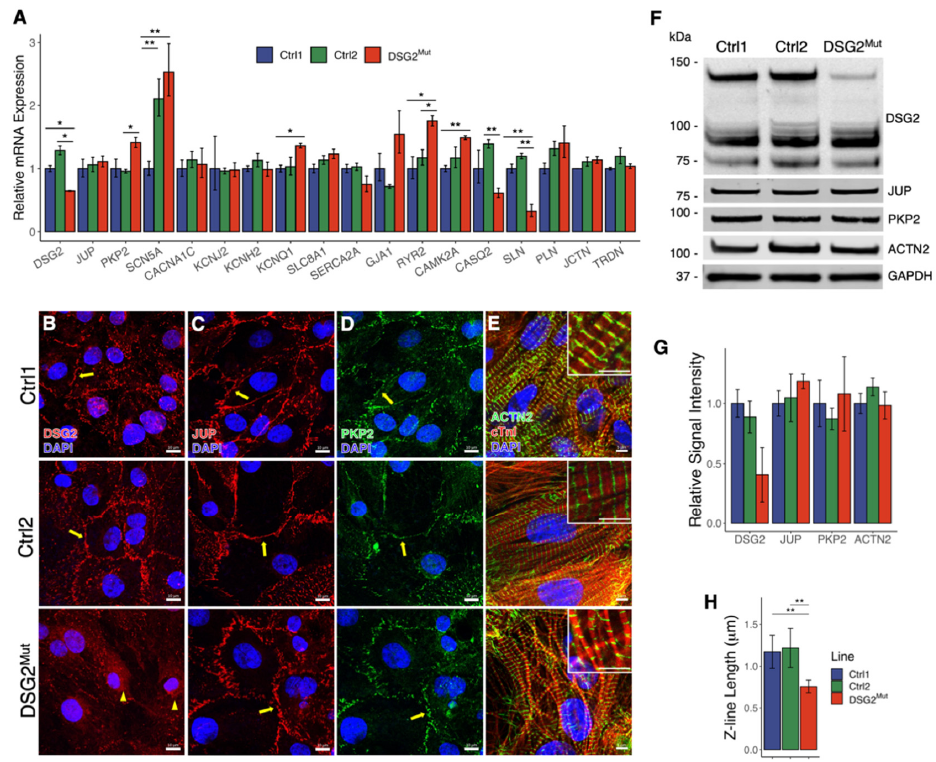
Figure 3. RT-qPCR, immunostaining and Western blot analyses of DSG2 Mut hiPSC-CMs. ( A ) RT-qPCR analysis of normal and DSG2 Mut hiPSC-CMs, normalized to Ctrl1. DSG2 primer targets a region upstream of the c.2358 deletion. n = 3 for all groups. ( B – E ) Representative control and DSG2 Mut hiPSC-CMs immunostained for desmosomal and structural proteins. Yellow arrows highlight presence of desmosomal proteins at cell-cell boundaries; yellow arrowheads denote perinuclear localization of DSG2. White scale bars: 10 µ m ( B – D ), 5 µ m ( E ). ( F ) Whole lysate western immunoblots of DSG2 Mut and control hiPSC-CMs, probed for desmosomal proteins and α -actinin (ACTN2). ( G ) Quantification of western blot signal intensity relative to GAPDH and normalized to Ctrl1. DSG2 was quantified using the full-length 130 kDa band. n = 3 for each line. ( H ) Z-line lengths quantified from confocal images of α -actinin immunostaining. Shorter Z-lines in DSG2 Mut cells correspond to narrower myofibrils. Two regions were randomly selected for quantification from three unique images of each line. * p < 0.05; ** p < 0.01.